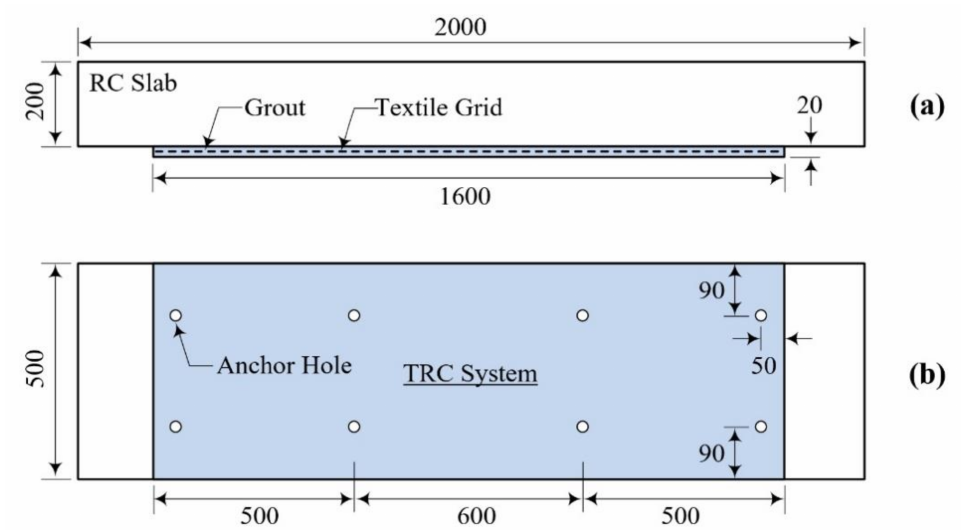
Figure 7. TRC-strengthening plan for RC slab: ( a ) side view; ( b ) bottom view (unit: mm).